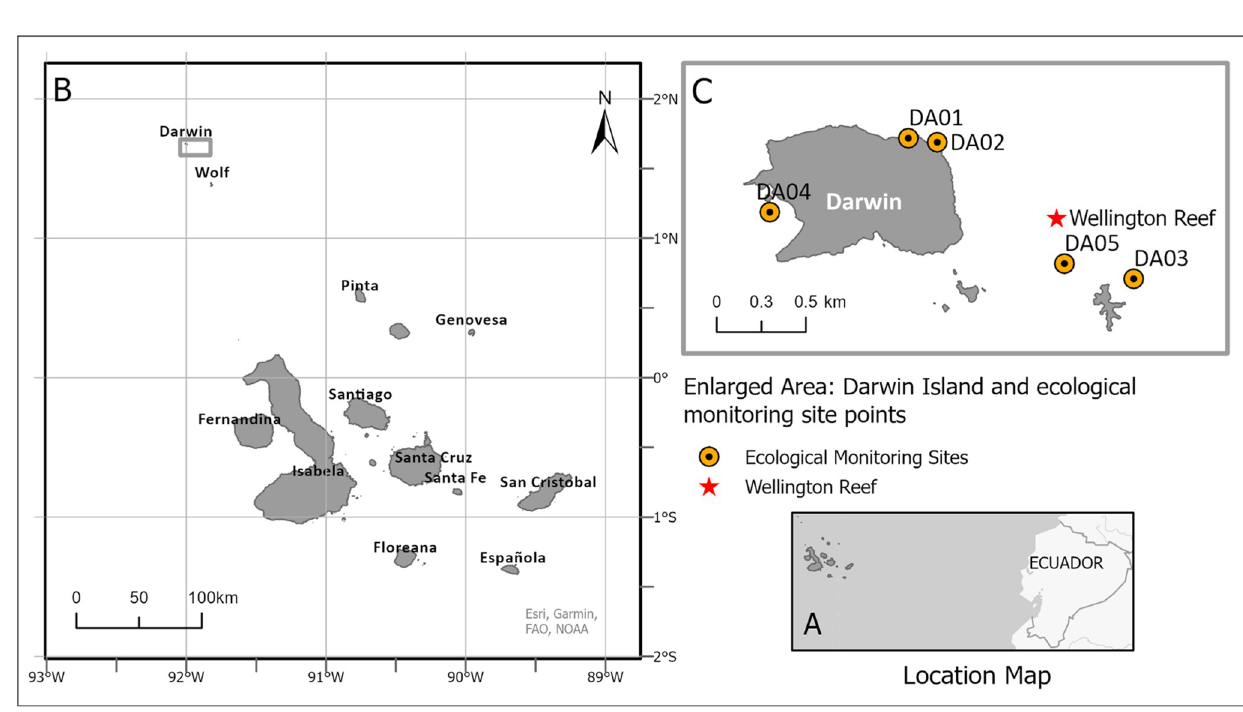
Fig 1. Location of Caulerpa chemnitzia study. (A) The Galapagos Islands are an archipelago off the coast of Ecuador (B) an overview of all islands, highlighting Darwin the northernmost island (C) 5 subtidal ecological monitoring sites and, Wellington reef, the site used for the collection of photo-transects